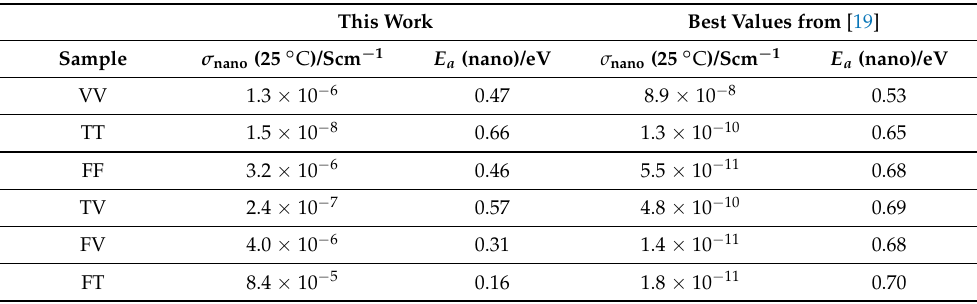
Table 4. Summary of total conductivities and activation energies of the samples obtained via the optimized nanocrystallization procedure. For comparison, the best data from previous work are